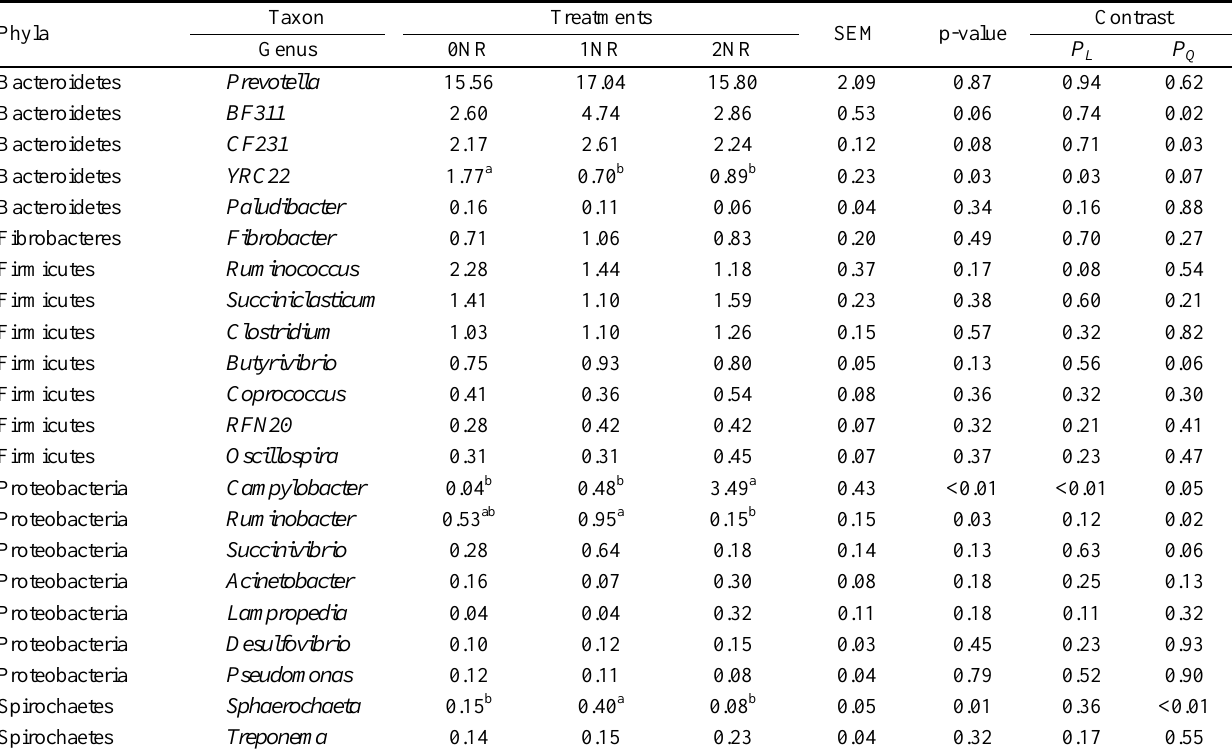
Table 3. Effects of nitrate on common classified bacteria genera in ruminal fluid ranked by average relative abundance (% of total sequences) using NGS